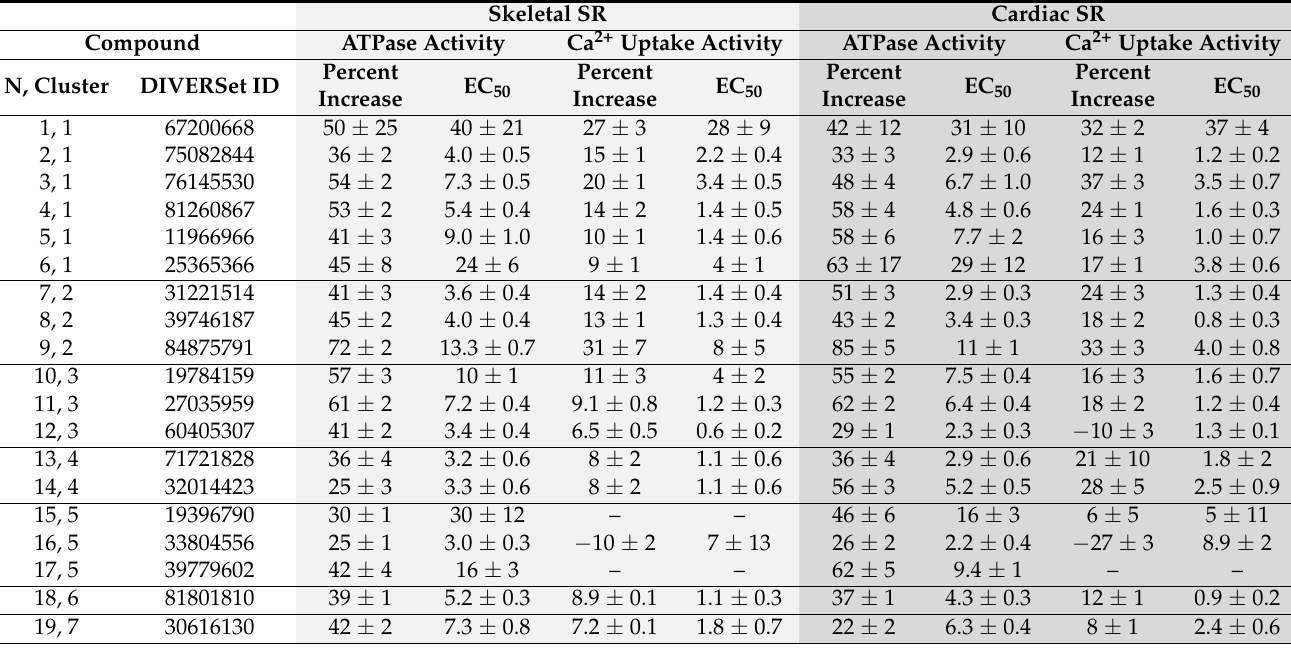
Figure 2. Representative CRC of SERCA-activating compound #12 for ATPase activity assay (% change in activity relative DMSO control) performed at pCa 5.4 in skeletal SR (V max ). Table 1. Summary of selected DIVERSet ATPase